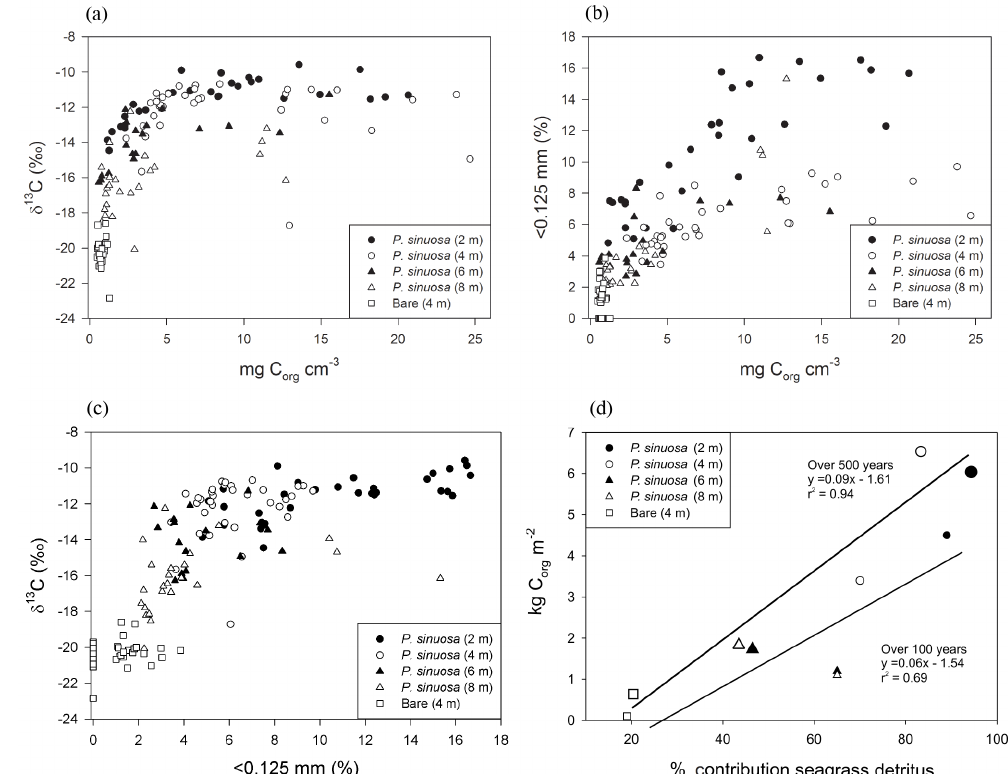
Figure 5. Biplots showing the relationships among the variables studied in the seagrass and bare sediment cores from Cockburn Sound (nor- malized for 500-year-old deposits). (a) δ 13 C signatures (‰) plotted against C org stocks (mg C org cm − 3 ) ; (b) sediment grain size <0.125mm (%) plotted against C org stocks (mg C org cm − 3 ) ; (c) δ 13 C signatures (‰) plotted against sediment grain size <0.125mm (%); and (d) contri- bution of seagrass detritus (%) plotted against soil C org stocks (kg C org m − 2 , over 100 years – small symbols – and 500 years – big symbols – of accumulation).